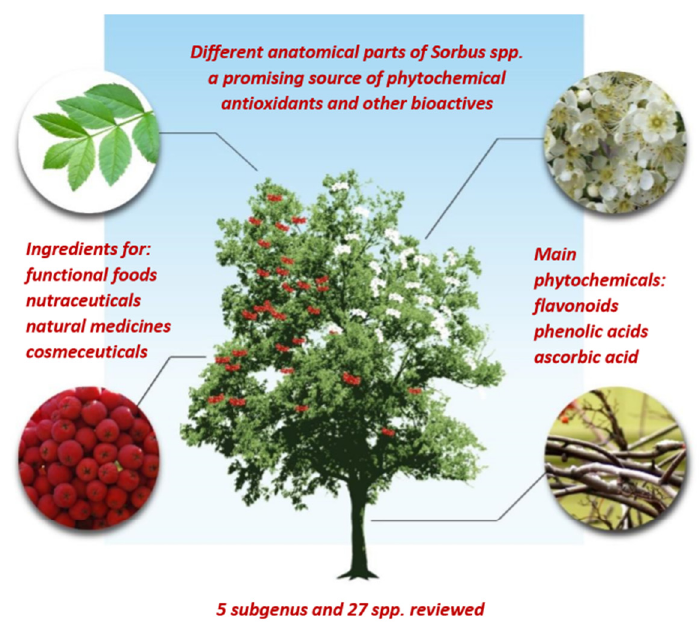
Figure 1. Potential uses of di ff erent parts of Sorbus